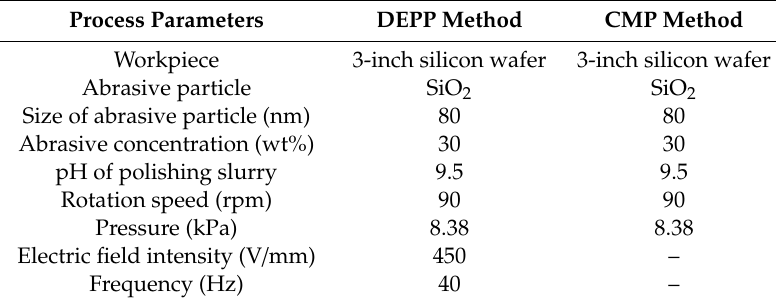
Table 9. Experimental